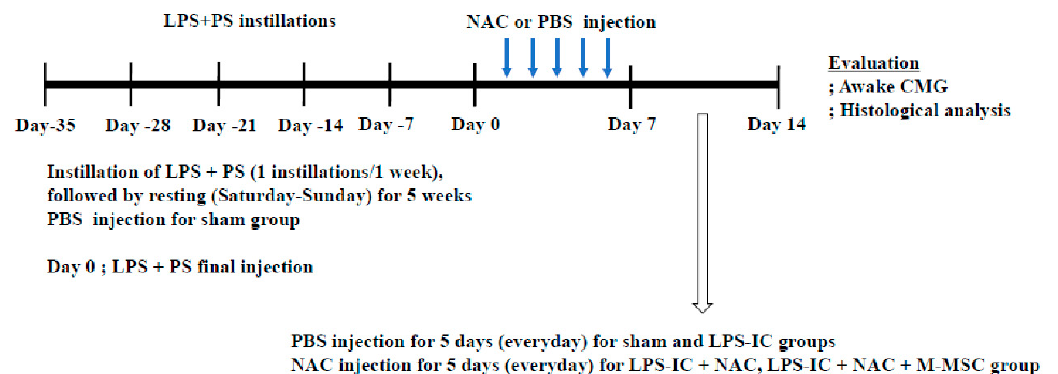
Figure 1. Schematic diagram of overall experiment. Ten female Sprague-Dawley rats were used in each group. The experimental control (LPS group) had PS and LPS instilled weekly for 5 weeks to induce chronic urothelial injury. Interventions involved a single administration of M-MSCs at a dose of 25K or 50K cells per 200 µ L PBS into the submucosal layer of the bladder or daily intraperitoneal injection of 200 mg / kg NAC at the indicated schedules. The sham group received PBS vehicle instead of MSC or NAC injection. LPS / PS: lipopolysaccharide / protamine sulfate; IC: interstitial cystitis; M-MSCs: multipotent mesenchymal stem cells; PBS: phosphate-bu ff ered saline; NAC: N-acetylcysteine; CMG: cystometry.